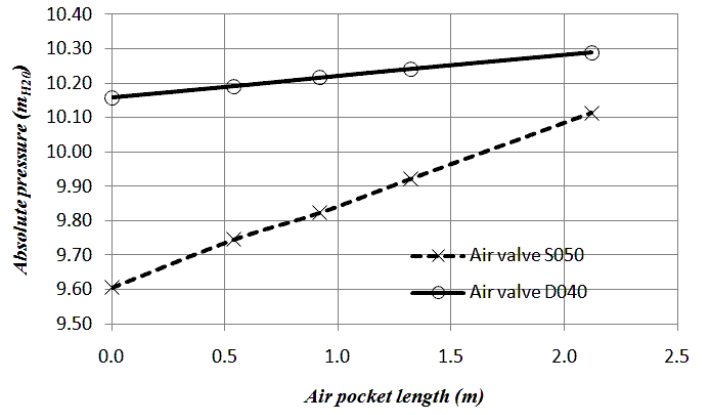
Figure 9. Effect of the air pocket sizes on the minimum pressure attained.